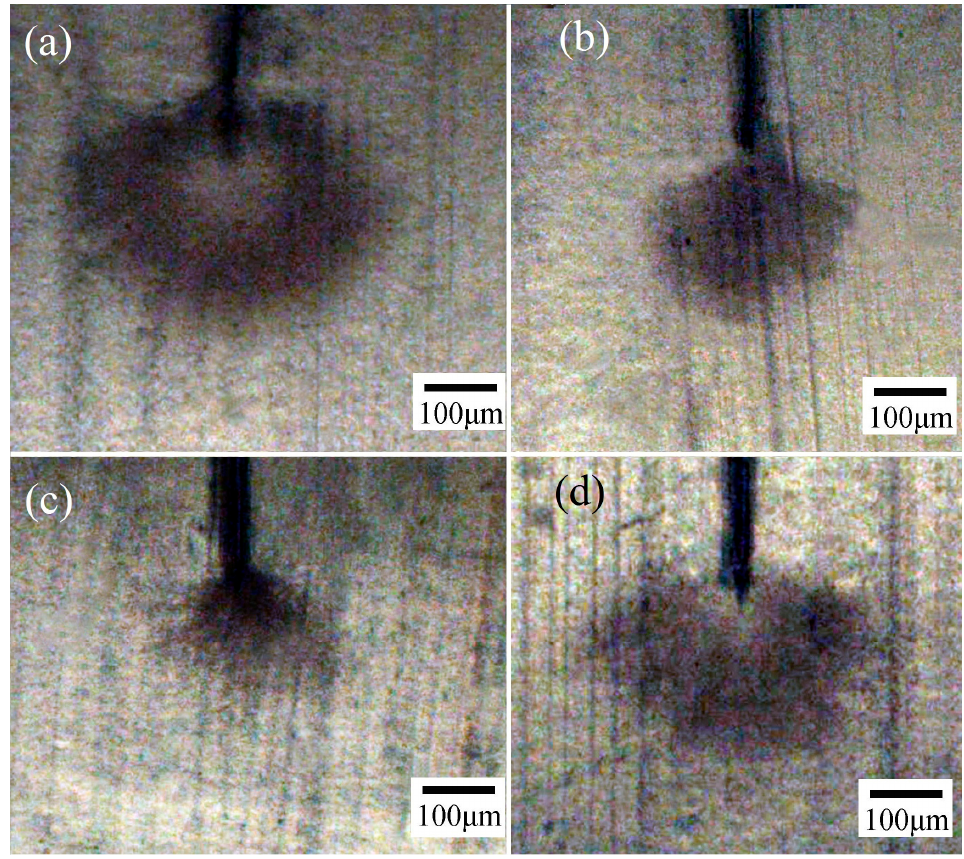
Figure 6. Water-tree morphology: ( a ) XLPE, ( b ) 0.5 wt%TMPTA-s-SiO 2 /XLPE, ( c ) 1.5 wt%TMPTA-s-SiO 2 /XLPE, ( d ) 1.5 wt% SiO 2 /XLPE.